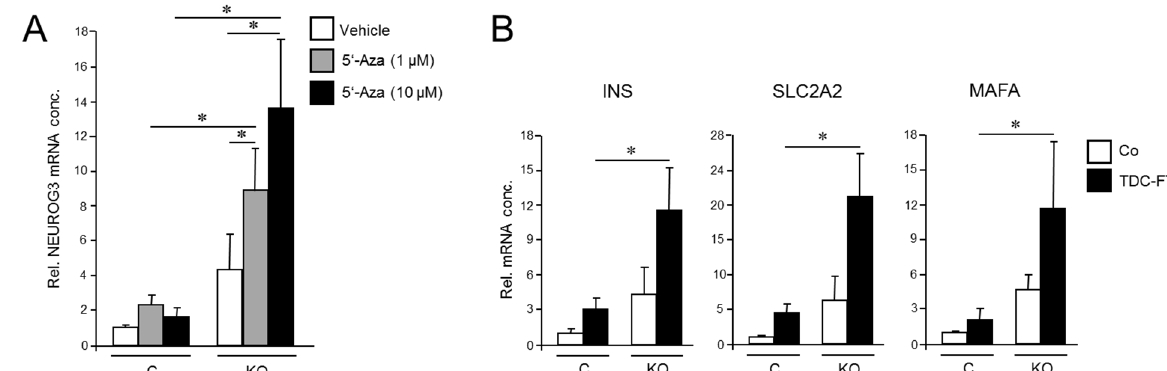
Figure 3. Cellular depletion of RAC1b enhances the conversion of PANC-1 cells into cells with a pancreatic endocrine or β cell-like phenotype. ( A ) PANC-1 RAC1b-KO (KO) and control ( C ) cells were treated or not for 3 d with two different concentrations of 5 (cid:48) -Aza in standard growth medium followed by another 3 d in growth medium without 5 (cid:48) -Aza. Cells were then subjected to qPCR for NEUROG3 . Data are from three independent experiments and represent the mean ± SD. Asterisks (*) indicate significant differences ( p < 0.05, Wilcoxon test). ( B ) As in ( A ), except that PANC-1 RAC1b-KO cells were subjected to FT-based TDC followed by qPCR for the indicated β cell markers. Data represent the mean ± SD of three ( INS , SLC2A2 ) or four ( MAFA ) independent experiments. Asterisks ( ∗ ) indicate significant differences ( p < 0.05, Wilcoxon test).